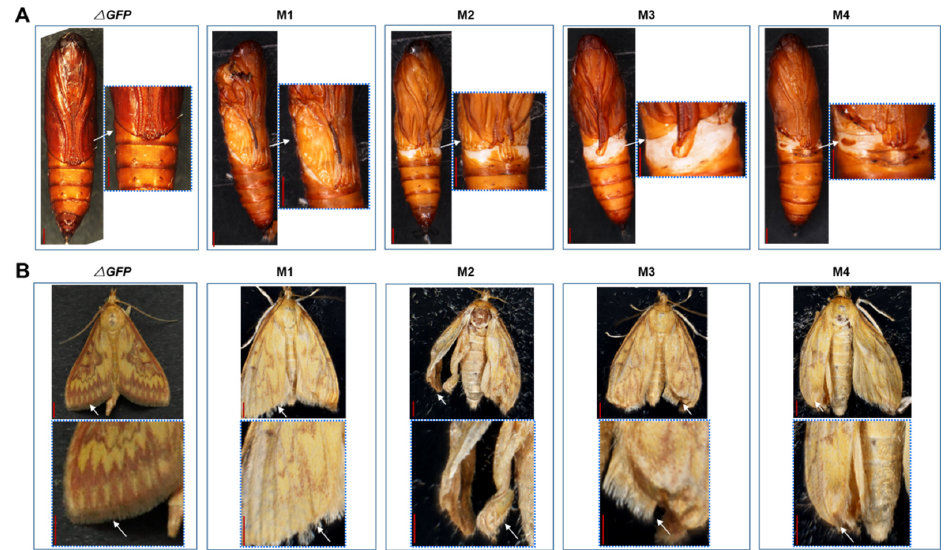
Figure 7. Wing deformation in OfUbx mutants at pupal and adult stages. ( A ) The phenotypes of OfUbx mutants in the larval stage. Arrows show abnormal and deficient wing discs. Bar = 0.3 mm. ( B ) The phenotypes of OfUbx mutants in the adult stage. Arrows show folded and deficient wings. Bar = 0.2 mm.